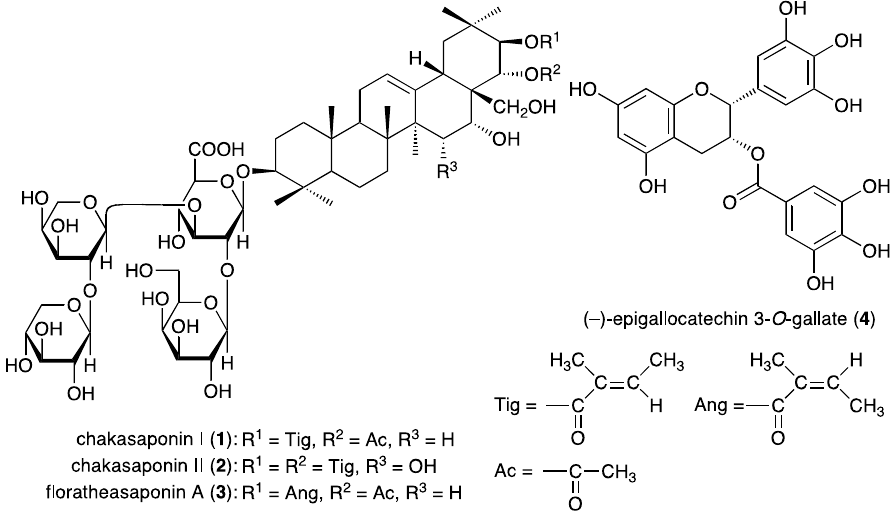
Figure 1. Structures of chakasaponins I ( 1 ) and II ( 2 ), floratheasaponin A ( 3 ), and (–)-epigallocatechin 3- O -gallate ( 4 ).